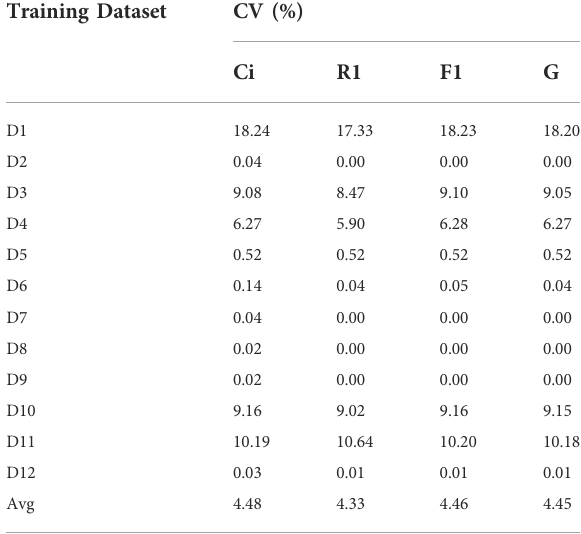
TABLE 3 Parameter dispersion in network